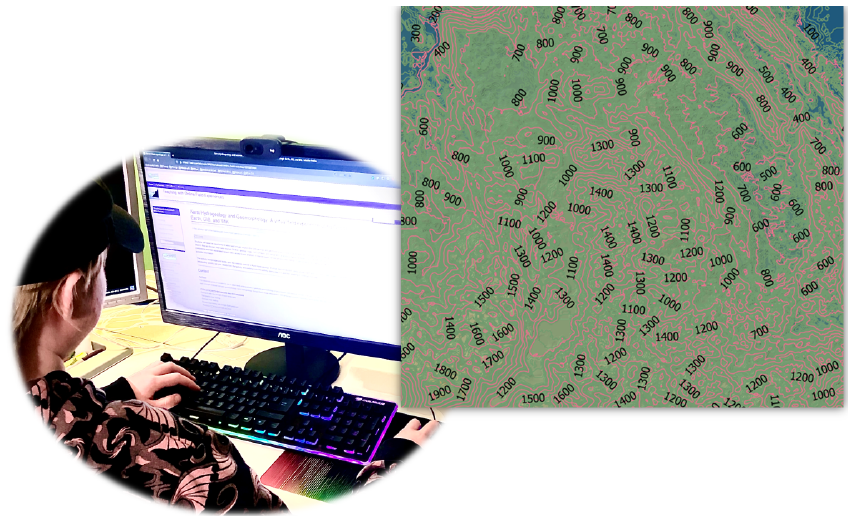
Figure 4. Sótano de las Golondrinas area with elevation contour layers. Photo by the author.